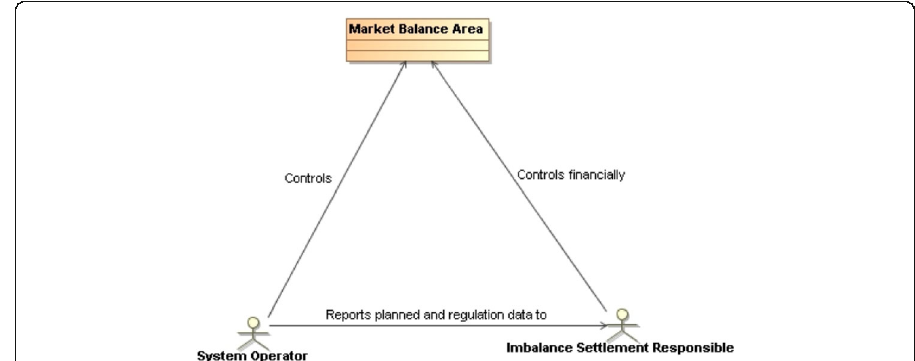
Fig. 9 An example of the role and domain relationships in harmonized role model (E. a. e. ENTSO-E